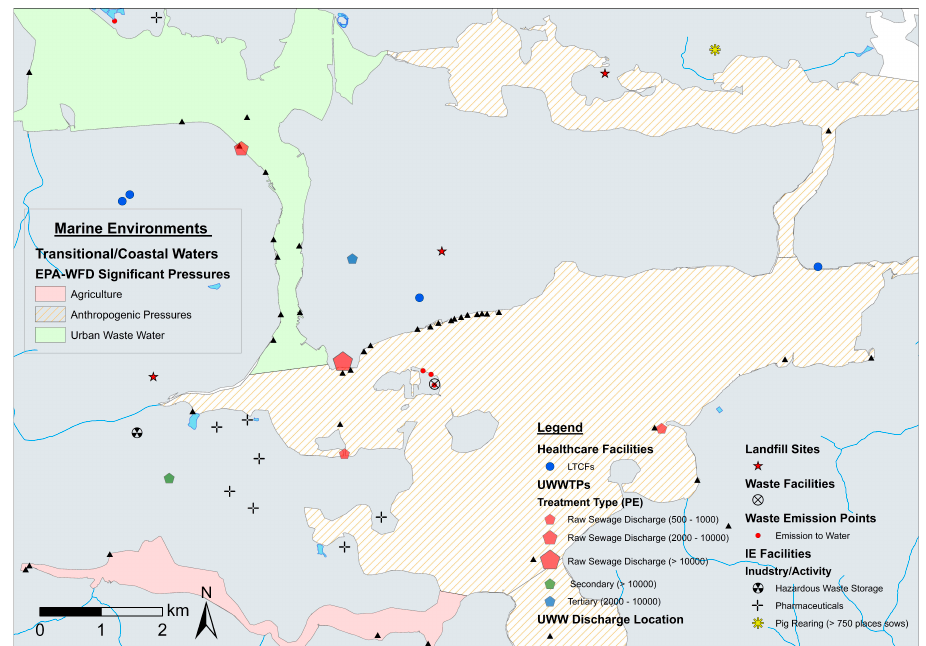
Figure 6. High resolution (fine-scale) map of potential ARO sources (classified) and healthcare facilities in Cork Harbour with coastal/transitional waters significant pressures. Notes: Environmental Protection Agency (EPA)-Water Framework Directive (WFD) coastal/transitional waters significant pressures data layers are also included. UWWTPs = urban wastewater treatment plants. UWW = urban wastewater. IE = industrial emissions. PE = population equivalent (i.e., estimated population served by